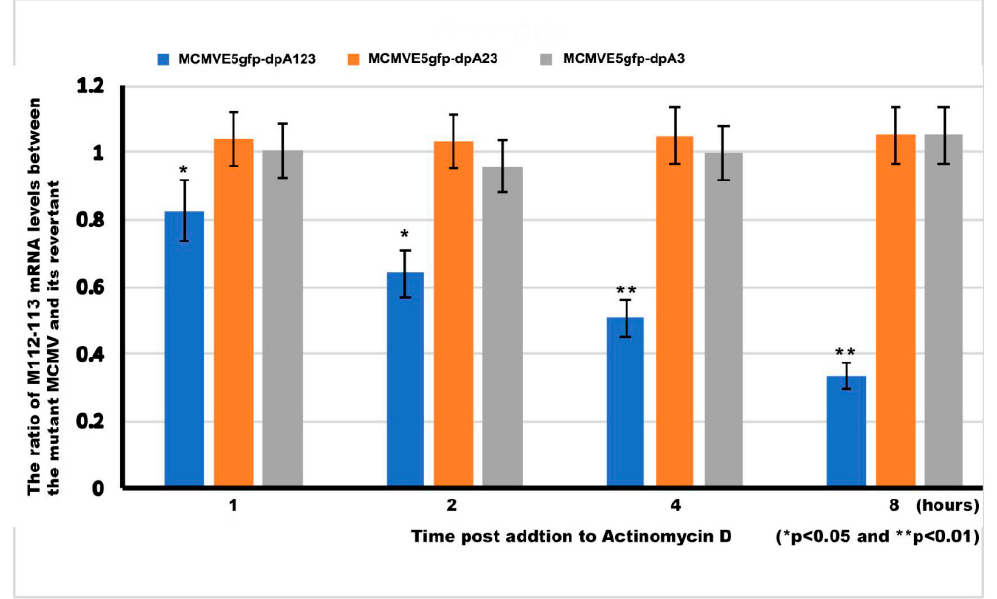
Figure 7. M112-113 mRNA stability assay. To know whether the poly(A) signals are important for the stability of M112-113 mRNA, we performed an mRNA stability assay according to previously reported protocol [25]. Briefly, we infected NIH3T3 cells with MCMVE5gfp_dpA3, MCMVE5gfp_dpA23, or MCMVE5gfp_dpA123 and their revertants at an MOI of 0.1. At the time of 20 h postinfection (hpi), 10 µg/mL actinomycin D was added to cells. The cells were collected for isolation of total RNA at time points of 1, 2, 4, and 8 h, following the actinomycin D addition. RT-qPCR was performed, as described above, for the M112-113 gene and GAPDH (Table 3). The levels of M112-113 mRNA were normalized with GAPDH, then the normalized M112-113 mRNA levels of MCMVE5gfp_dpA3, MCMVE5gfp_dpA23, or MCMVE5gfp_dpA123 were compared to the revertant of each mutated MCMV. A t -test was used to compare the differences between the groups, * p < 0.05, and ** p < 0.01.